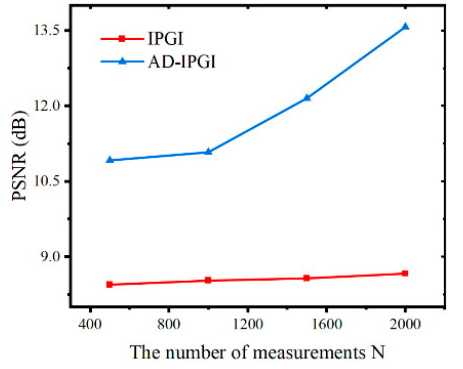
Figure 7. The PSNR curves of the image “Slits”.